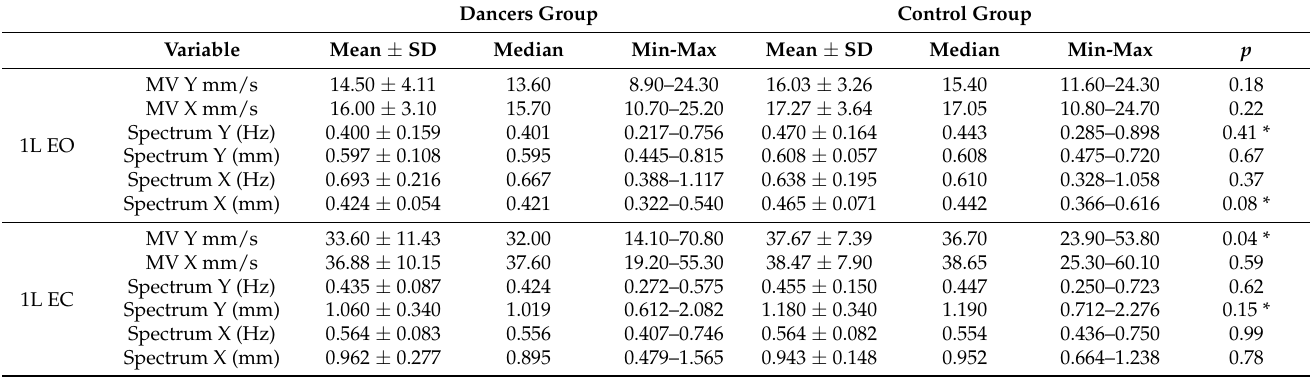
Table 5. Comparison of results obtained in the one-leg standing position with eyes open (1L EO) and eyes closed (1L EC) in the dancer and control groups. Dancers